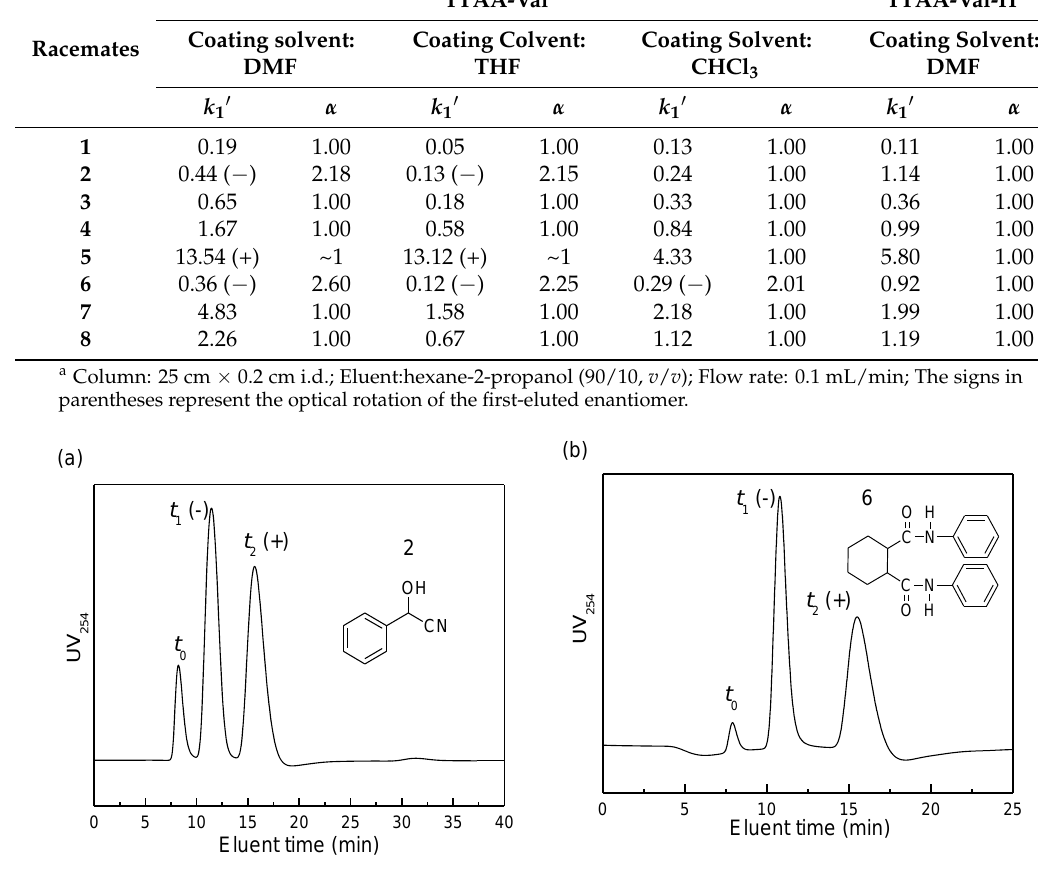
Figure 7. Chromatograms for the resolution of ( a ) 2 and ( b ) 6 on PPAA-Val coated with DMF with hexane/2-propanol (90/10) as eluent.